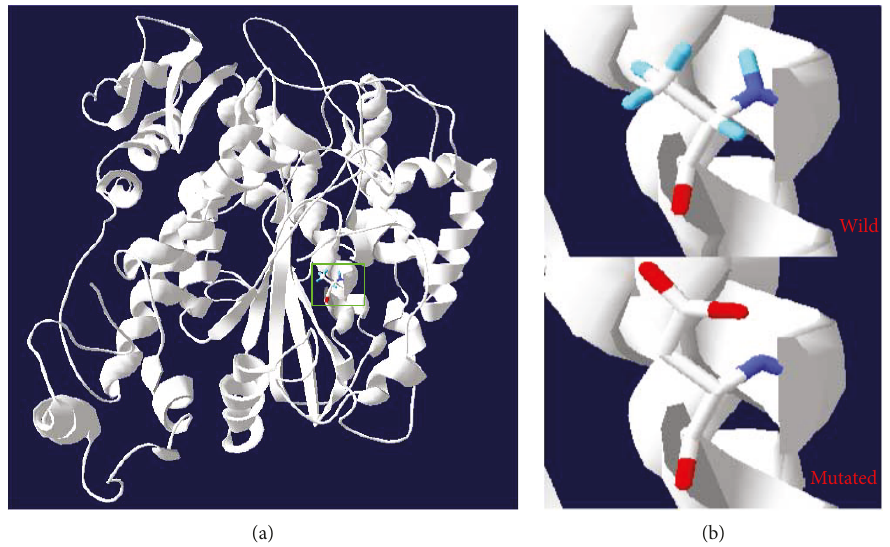
Figure 3: Structure modeling of wild-type and mutated MYO15A motor domain. (a) Green box shows the complete MYO15A motor domain. (b) The detailed structure of wild and mutated p.A1324